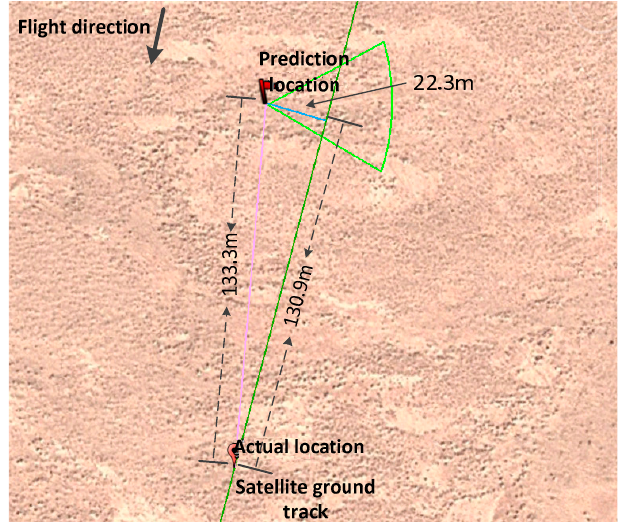
Figure 14. Error graph between the predicted location and actual value.